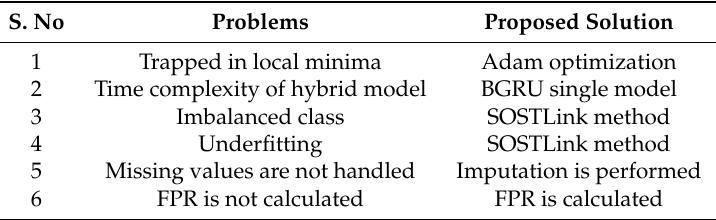
Table 1. Mapping of problems with